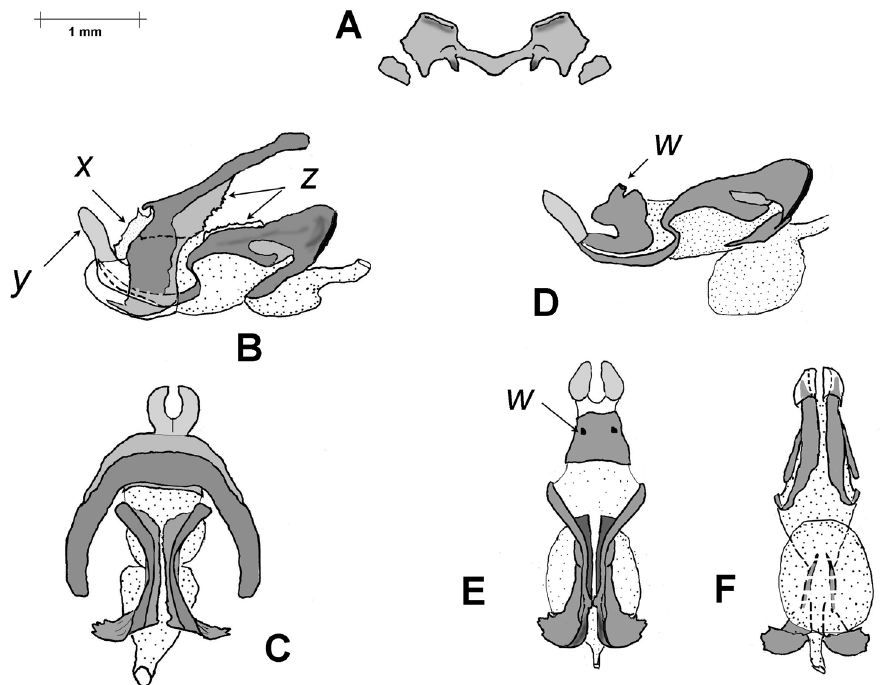
Fig. 4. Aresceutica subnuda , phallus. A. Epiphallus and oval sclerites, axial view; B. Phallic complex after removal of epiphallus and epiphallic membrane, lateral view. x: cut edge of epiphallic membrane. y: aedeagal sheath. z: chitinous fringe to ectophallic ramus and basal endophallic sclerites; C. As in B, but dorsal view; D. Endophallus and arch of cingulum, lateral view. w: cut attachment of arch to zygoma; E. As D, but dorsal view; F. As D, but ventral view.